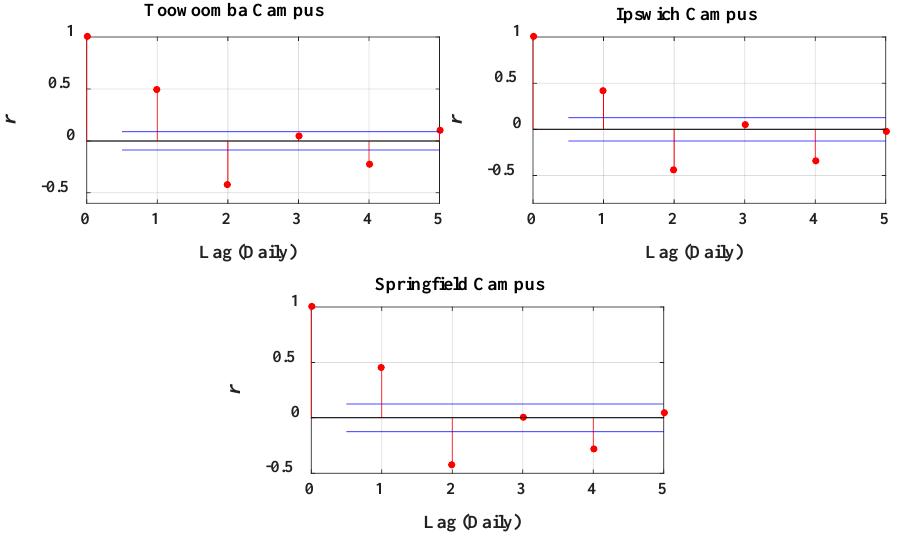
Figure 3. The model input variables constructed from the statistically significant lags at a 95% confidence interval from the original daily G -datasets in the training period for the three study sites based on correlation coefficient ( r ) of predictors (lags) using the partial autocorrelation function (PACF).